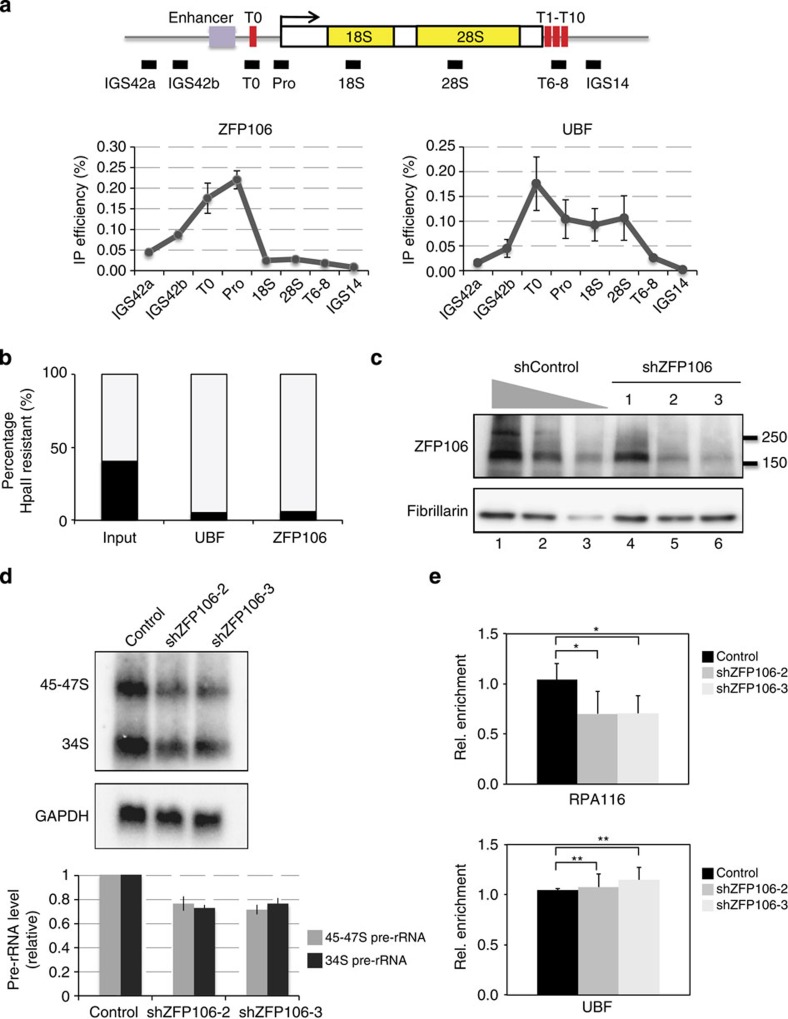
Validation of ZFP106 as a true and important rDNA promoter-binding protein.(a) Chromatin immunoprecipitation of ZFP106 using anti-ZFP106 antibody and anti-UBF antibody. Immunoprecipitated (IP) DNA relative to input were quantified by real-time quantitative PCR. Top: Map of regulatory sequence elements on rDNA unit. The thick black line shows the position of PCR amplicons. (b) ChIP-chop experiment to measure DNA methylation level 275 bp downstream of the rDNA promoter in IP DNA with anti-UBF, anti-ZFP106 and input DNA. See the details in Supplementary Fig. 5. (c) Western blotting analysis for ZFP106 and fibrillarin after knockdown by three independent shRNA constructs. Whole protein extract after knockdown with shControl (lane 1: 100%, lane 2: 50%, lane 3: 20% of the extract) and the protein extract in the cells expressing three shRNA for ZFP106 were analysed (lanes 4–6). (d) Northern blotting analysis of pre-rRNA levels. Pre-RNA, 45–47S rRNA and 34S rRNA were detected by the ETS3 oligoprobe and glyceraldehyde 3-phosphate dehydrogenase (GAPDH) messenger RNA (mRNA) was detected by a specific oligoprobe. The bars represent pre-rRNA levels (45–47S and 34S) normalized to GAPDH mRNA from three experiments. (e) ChIP analysis of the second biggest subunit of RNA polymerase I (RPA116) and UBF on rDNA in the cells expressing shControl and two shRNA for ZFP106. Immuno precipitated DNA relative to input were quantified by real-time quantitative PCR for the rDNA promoter region (Pro) and then normalized to control reactions from shControl-transfected cells. Three independent experiments were performed and error bars represent standard deviation. Stars denote significances, *P<0.01, and **P>0.2 from a Student’s t-test.